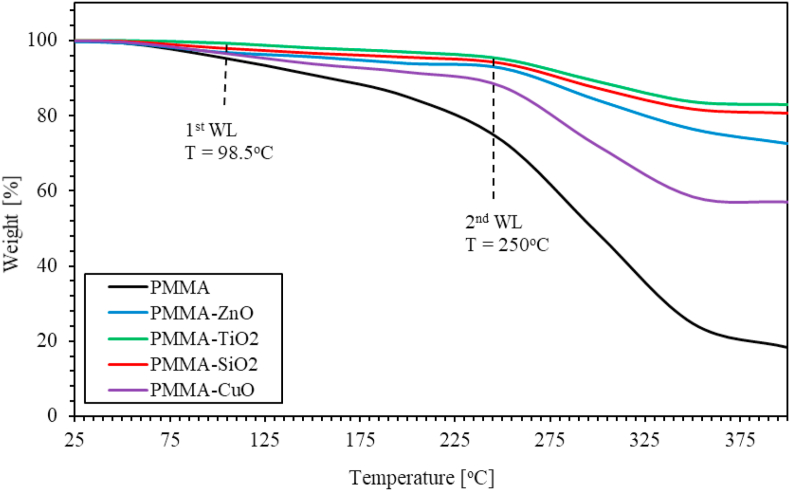
The TGA thermograms of pure PMMA, and PMMA incorporated with ZnO, TiO2, SiO2 and CuO NPs nanocomposites.